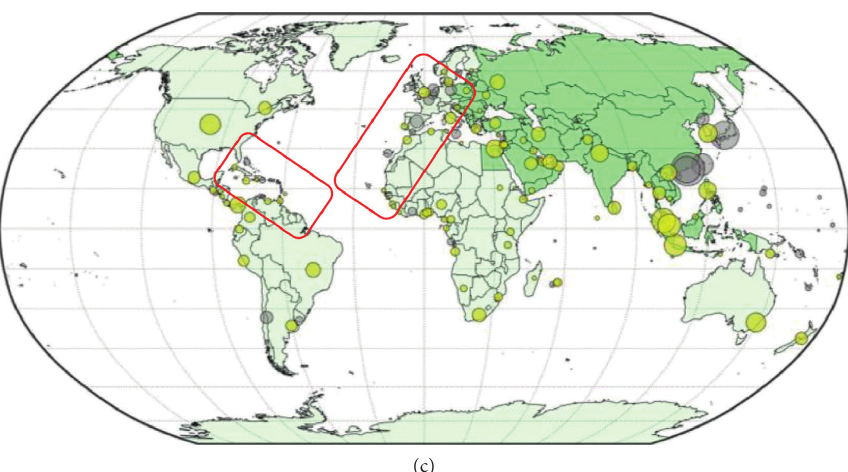
Figure 17: China’s overseas construction projects coupled with the national shipping network (No. 6). (a) Coupled with the global maritime network of significances (PageRank centrality); (b) coupled with the global maritime network of flows (degree centrality); (c) coupled with China’s maritime flows.